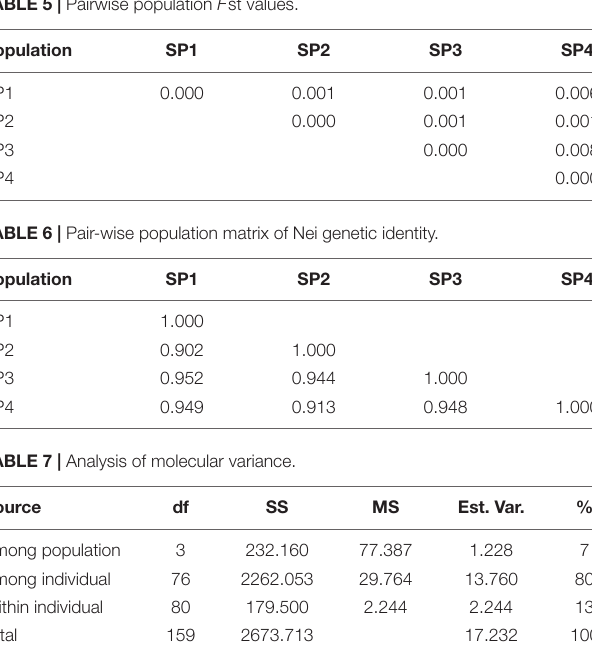
TABLE 5 | Pairwise population F st values.